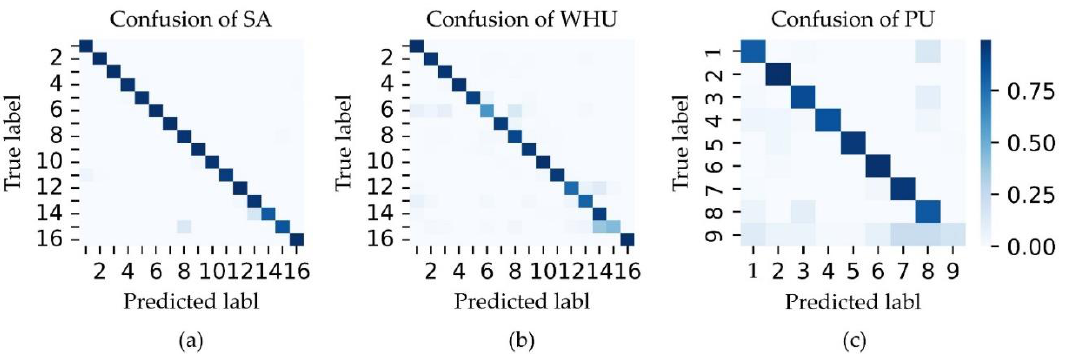
Figure 7. The confusion matrices of MDAN in the three selected datasets: ( a ) the confusion of the SA dataset; ( b ) the confusion of the WHU dataset; ( c ) the confusion of the PU